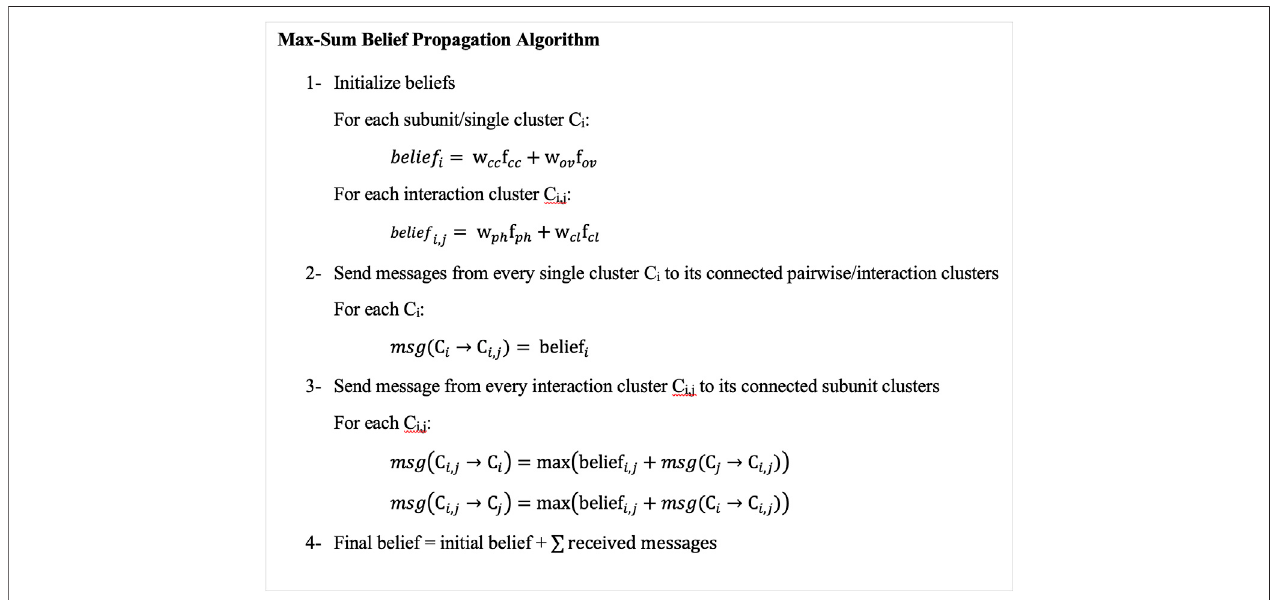
FIGURE2| OverviewoftheMax-SumBeliefPropagationAlgorithm.Thealgorithmhasfourmainsteps.1,itinitializesthebeliefsofsubunit/singleclusters(nodes)to be the sum of the weighted goodness-of- fi t scores of their candidate poses, and the beliefs of interaction/pairwise clusters (nodes) to be the sum of the weighted pairwise scores between the poses of every pair of subunits. 2, subunit clusters (nodes) send their initial beliefs to their connected pairwise clusters (nodes). 3, pairwise clusters (nodes) send messages to their connected subunit clusters (nodes) containing the sum of the pairwise initial beliefs and the subunit messages they received from subunit clusters (nodes), excluding the receiving cluster (node) messages. 4, subunit clusters (nodes) add pairwise beliefs to their initial beliefs. This algorithm corresponds to the right-bottom graph in Figure 1 , which is called a cluster graph. A node in the cluster graph is also called a cluster, and thus we used the term cluster and nodes